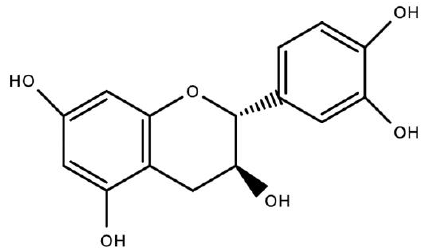
Figure 3. Catechin structure.